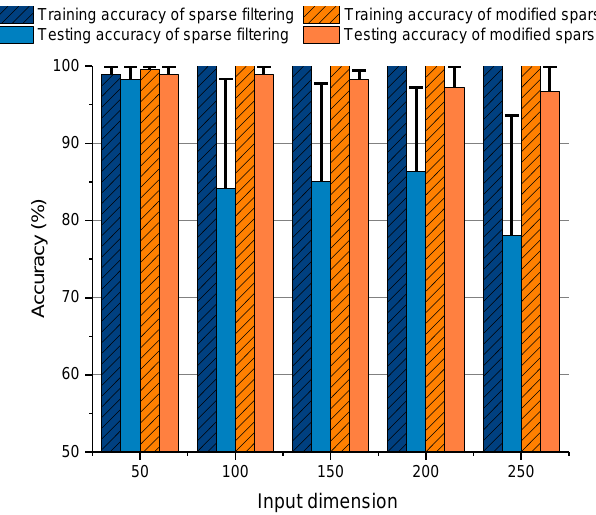
Figure 17. Diagnosis result using various input dimensions of modified and original sparse filtering.